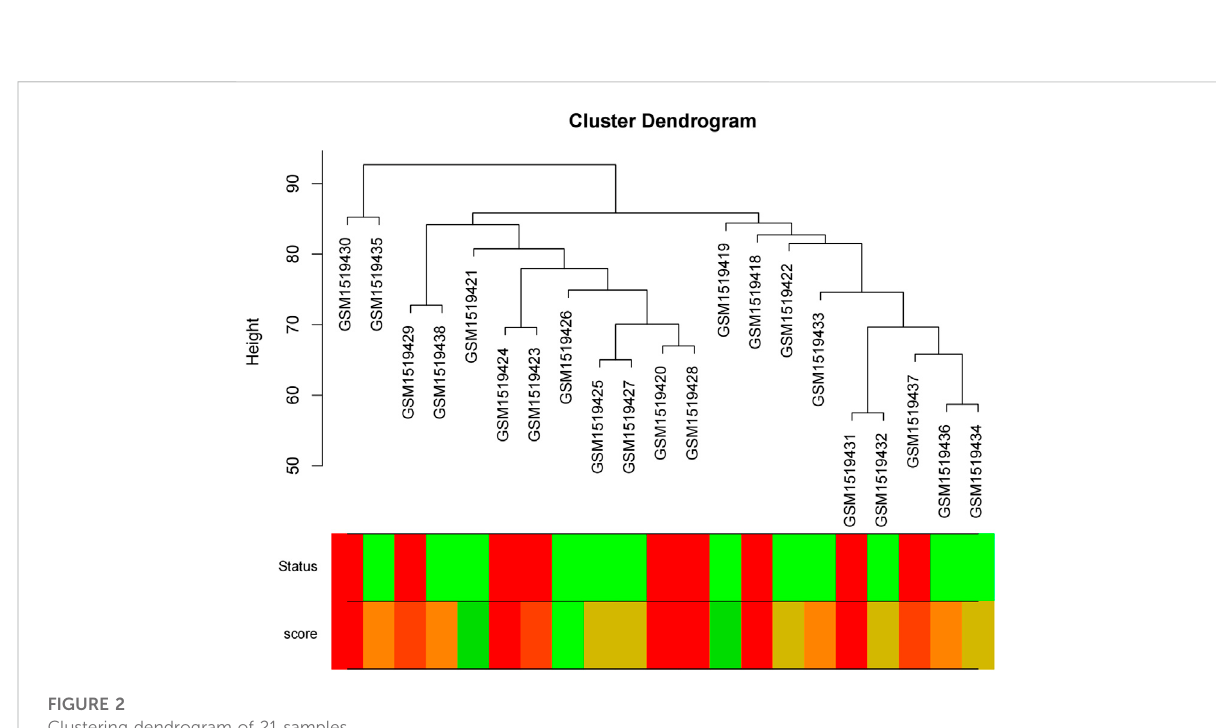
FIGURE 2 Clustering dendrogram of 21